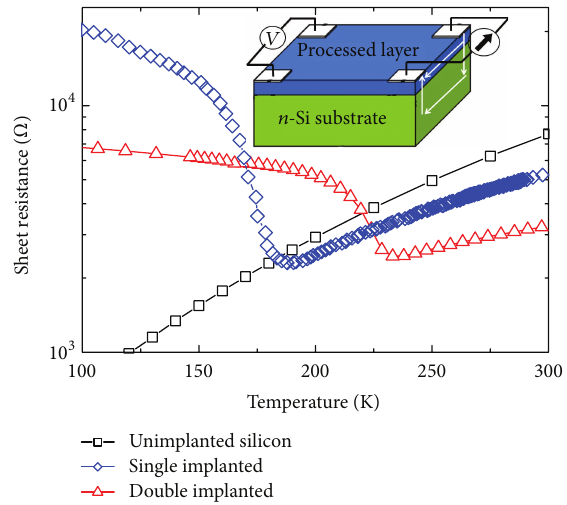
Figure 4: Sheet resistance as a function of temperature measured for the single Ti implanted and the double Ti implanted samples. A Si reference substrate is used for comparison purposes. Inset shows a schematic 3D view of the final processed sample and the van der Pauw set-up for electrical